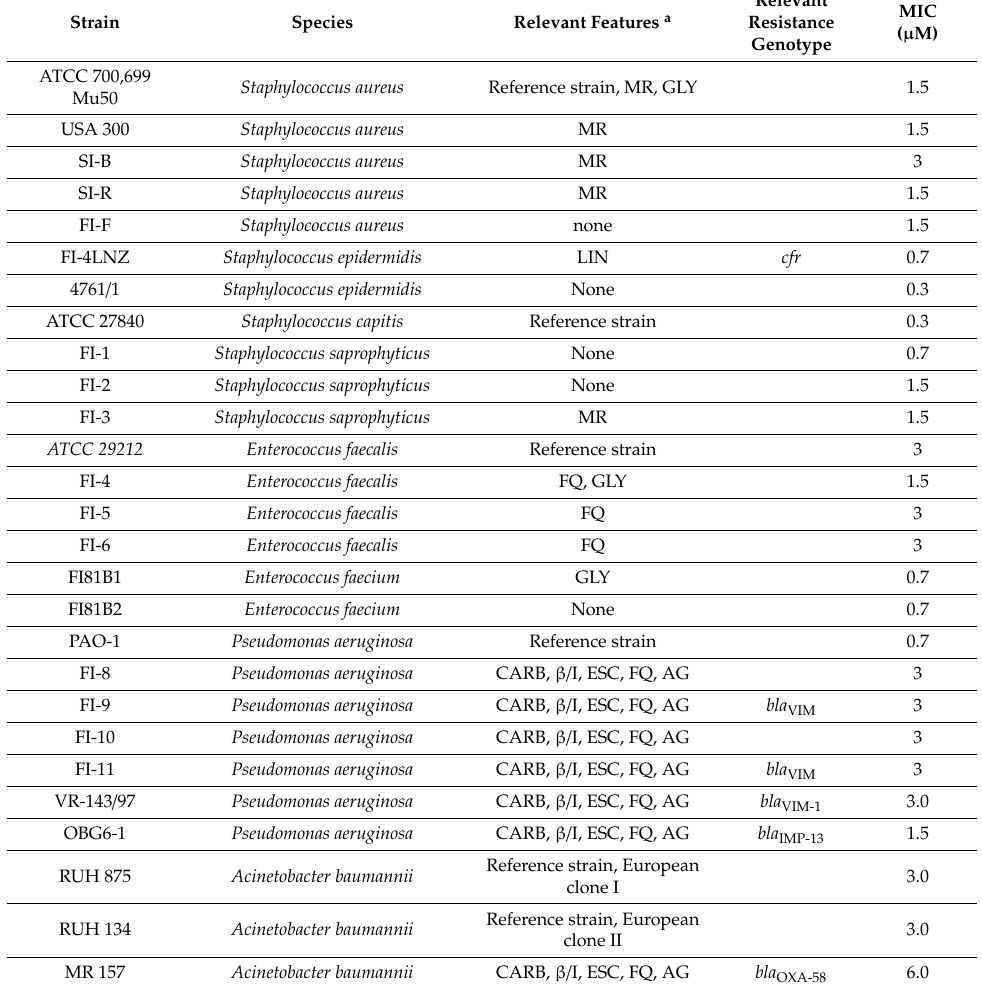
Table 1. MIC values of SET-M33D peptide on selected strains of major pathogen species. Strain Species Relevant Features a